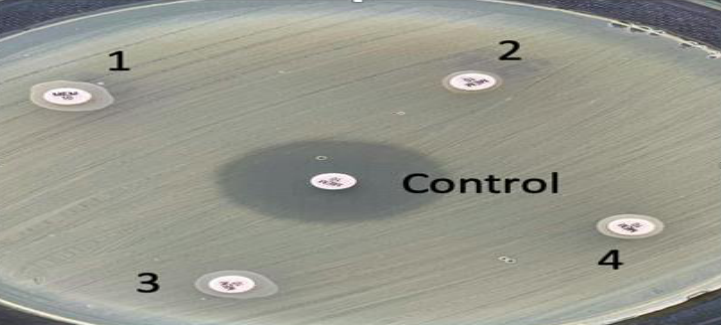
Figure 1. the results of mCIM for four CPE strains (1 – 4) showing no zones of inhibition around the meropenem disc (10 ug).